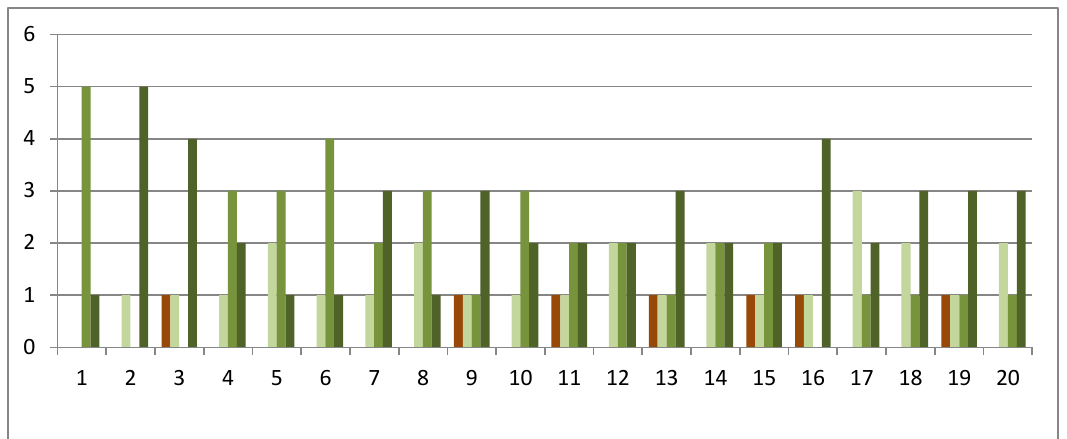
Figure 2. Announcements of green goods in NEUTRAL FRAME Treatment, per period and market.